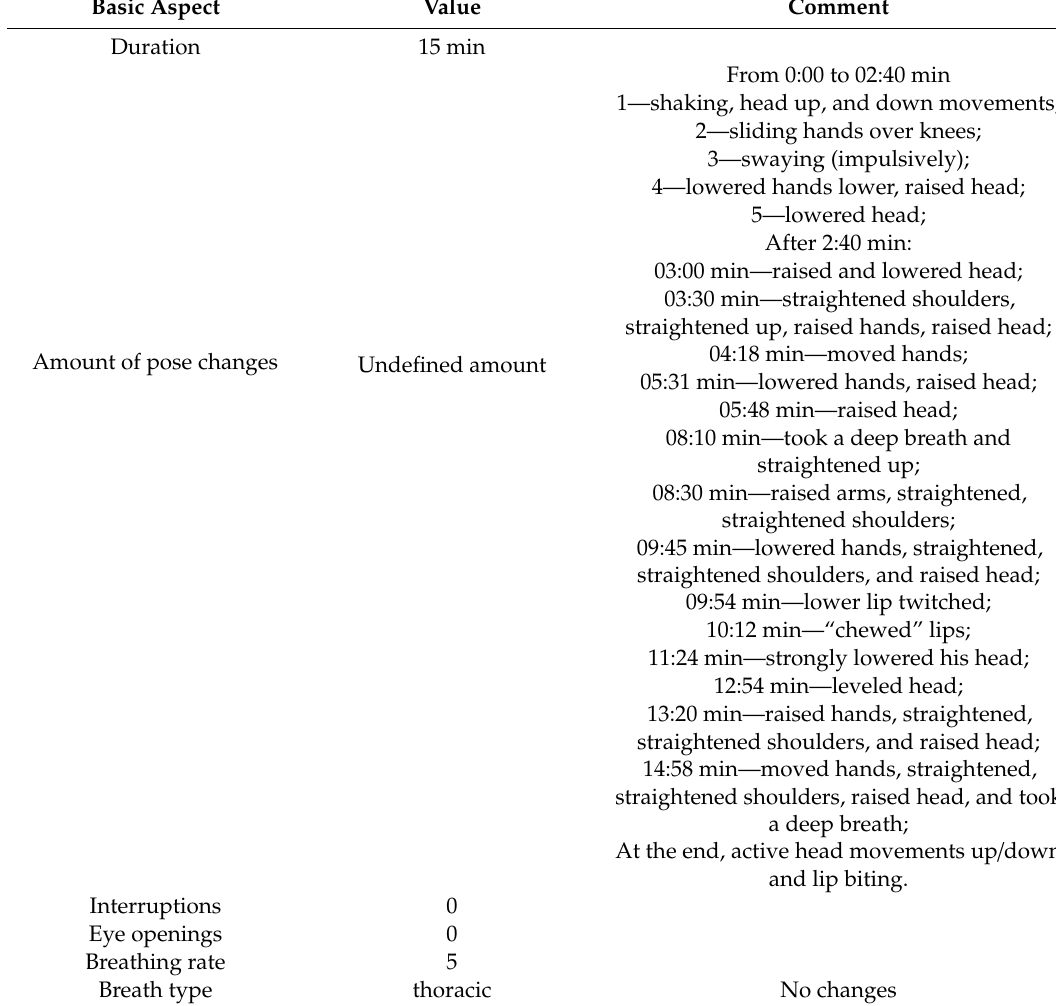
Table 4. Example of meditation analysis process done by a